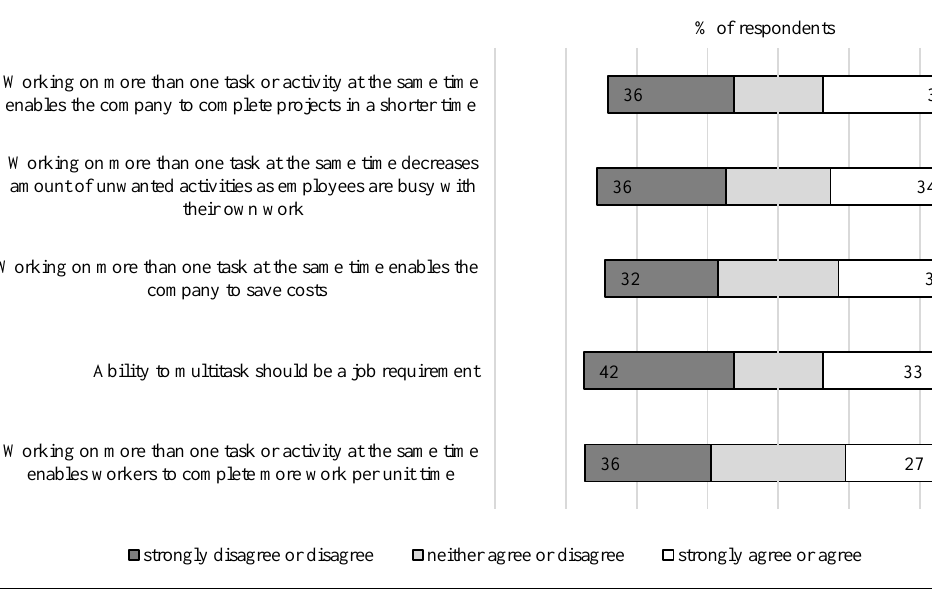
Figure 3. Perception of the positive and negative effects of multitasking at the level of a